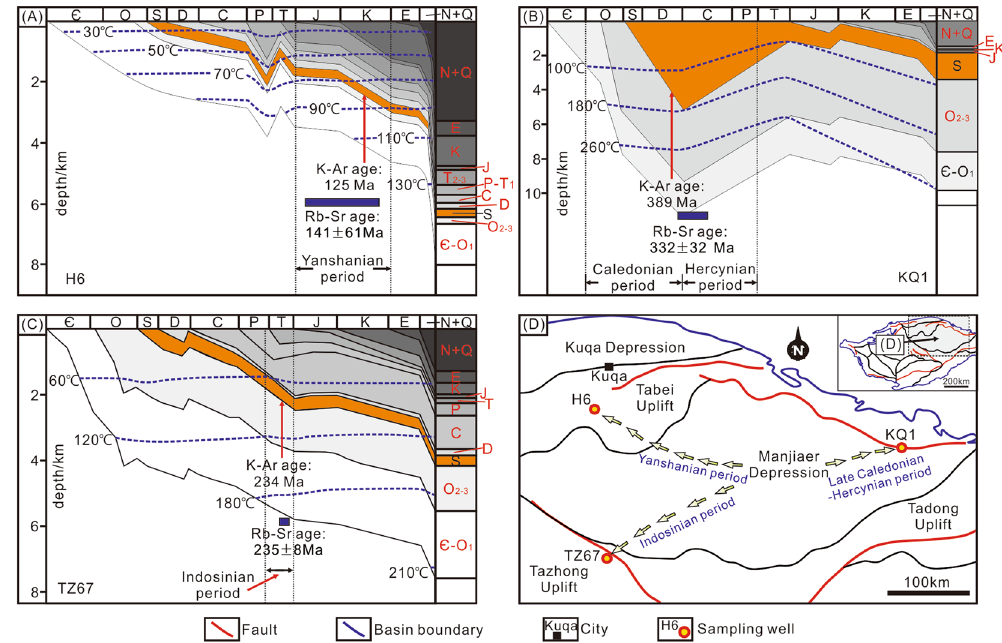
Figure 9. Based on the Rb-Sr and K-Ar age data and basin modelling results, the timing of hydrocarbon charge in the SBS of is constrained: ( A ) H6, Yanshanian period; ( B ) KQ1, Late Caledonian to Hercynian period and ( C ) TZ67, Indosinian period. ( D ) Generalized map showing the timing of hydrocarbon charge.